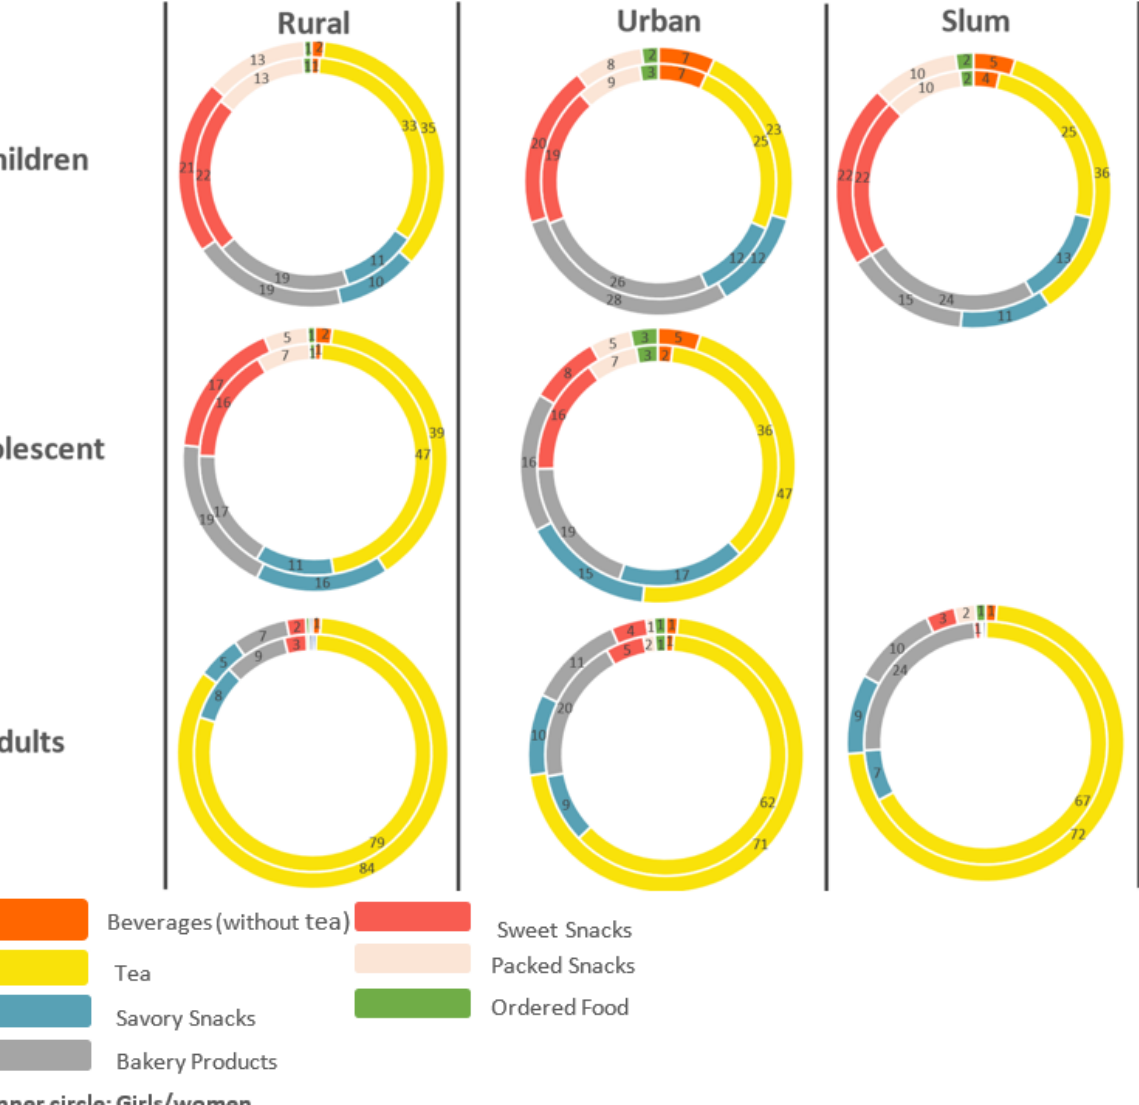
Figure 2. Percentage distribution of monthly frequency of different snacks across groups. Results from the multivariate regression analysis in Table 2 show determinants of SFC. After controlling for co-variates, women have a higher monthly frequency of SFC. Other significant determinants of SFC were migration, parents with literacy, screen time, type of school (government and private), and company of